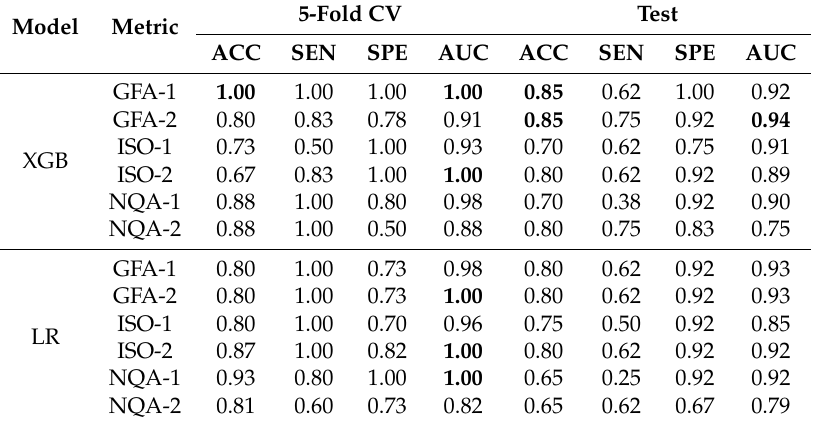
Table 3. The results of identifying ideation subjects from HCs and depression subjects by XGB and LR are the highest of a 10-time train_test_split iteration. The data of HCs and depression subjects was split into two halves ( − 1 and − 2) to reduce imbalance. Note that the maximum values presented in a row came from a single prediction that attained the highest AUC. ACC, accuracy; AUC, area under curve; SEN, sensitivity; SPE,